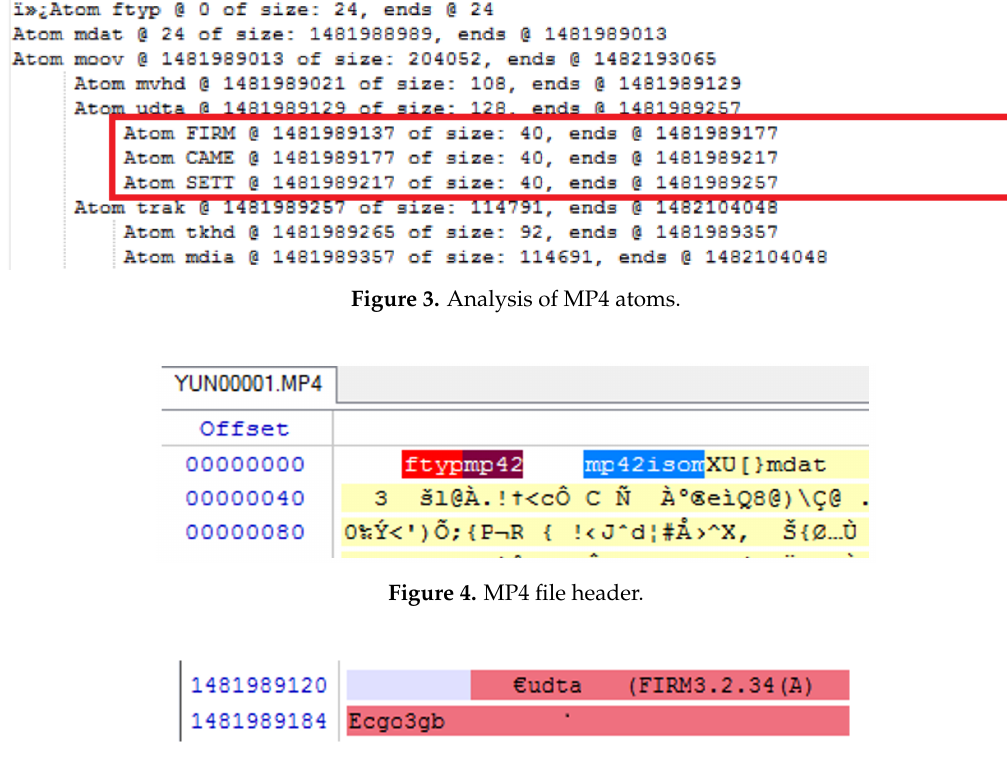
Figure 5. Camera information header (the vital atom/box in media files in this